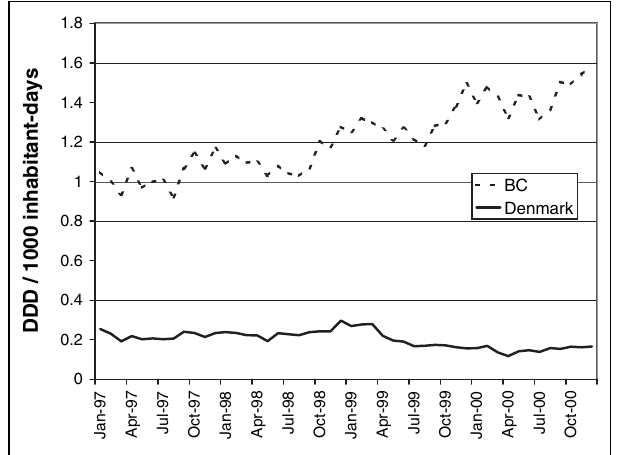
Figure 6) Comparison of rates of consumption of class J01MA fluoro- quinolones in British Columbia (BC) and Denmark with different Y-axes. BC is on the left, Denmark is on the right. DDD Defined Daily Dose